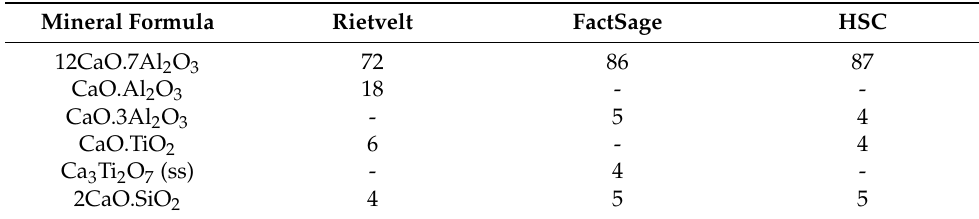
Table 6. Comparison of the phase distribution between HSC, FactSage, and Rietvelt results for the S-CB-open. Mineral Formula Rietvelt FactSage HSC 12CaO.7Al 2 O 3